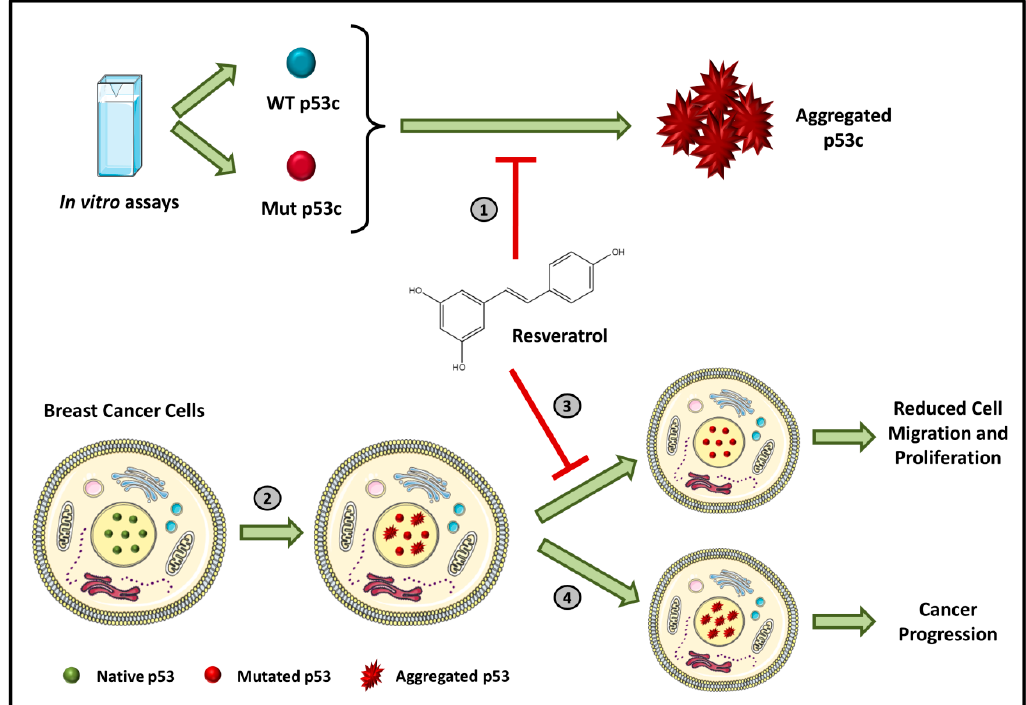
Figure 2. Schematic representation of p53 inhibition by resveratrol. In ( 1 ), the resveratrol in vitro capacity of inhibition of both WT and mutant p53 aggregation is described. ( 2 ) When mutations in the TP53 gene appear, the protein produced is less stable and forms aggregates. These aggregates are related to a direct effect in cancer proliferation and migration that is inhibited by treatment with resveratrol ( 3 ). Otherwise, cancer progression occurs ( 4 ). Extracted from Ferraz da Costa, 2018 [21].